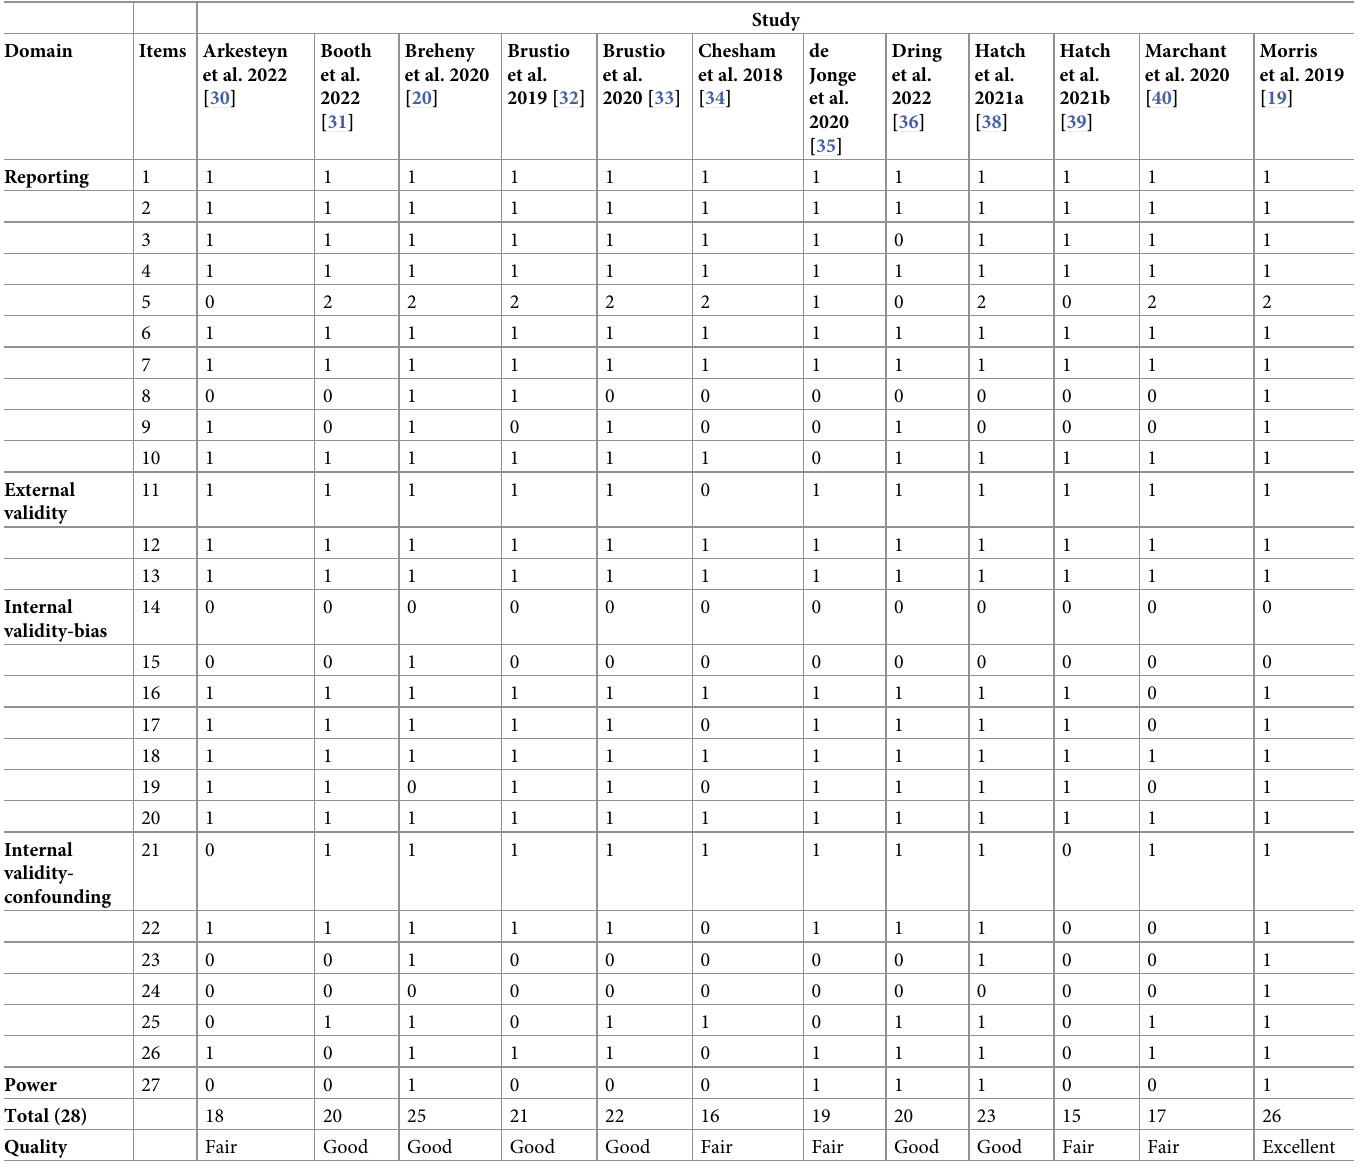
Table 3. Modified downs and black quality checklist scoring for included